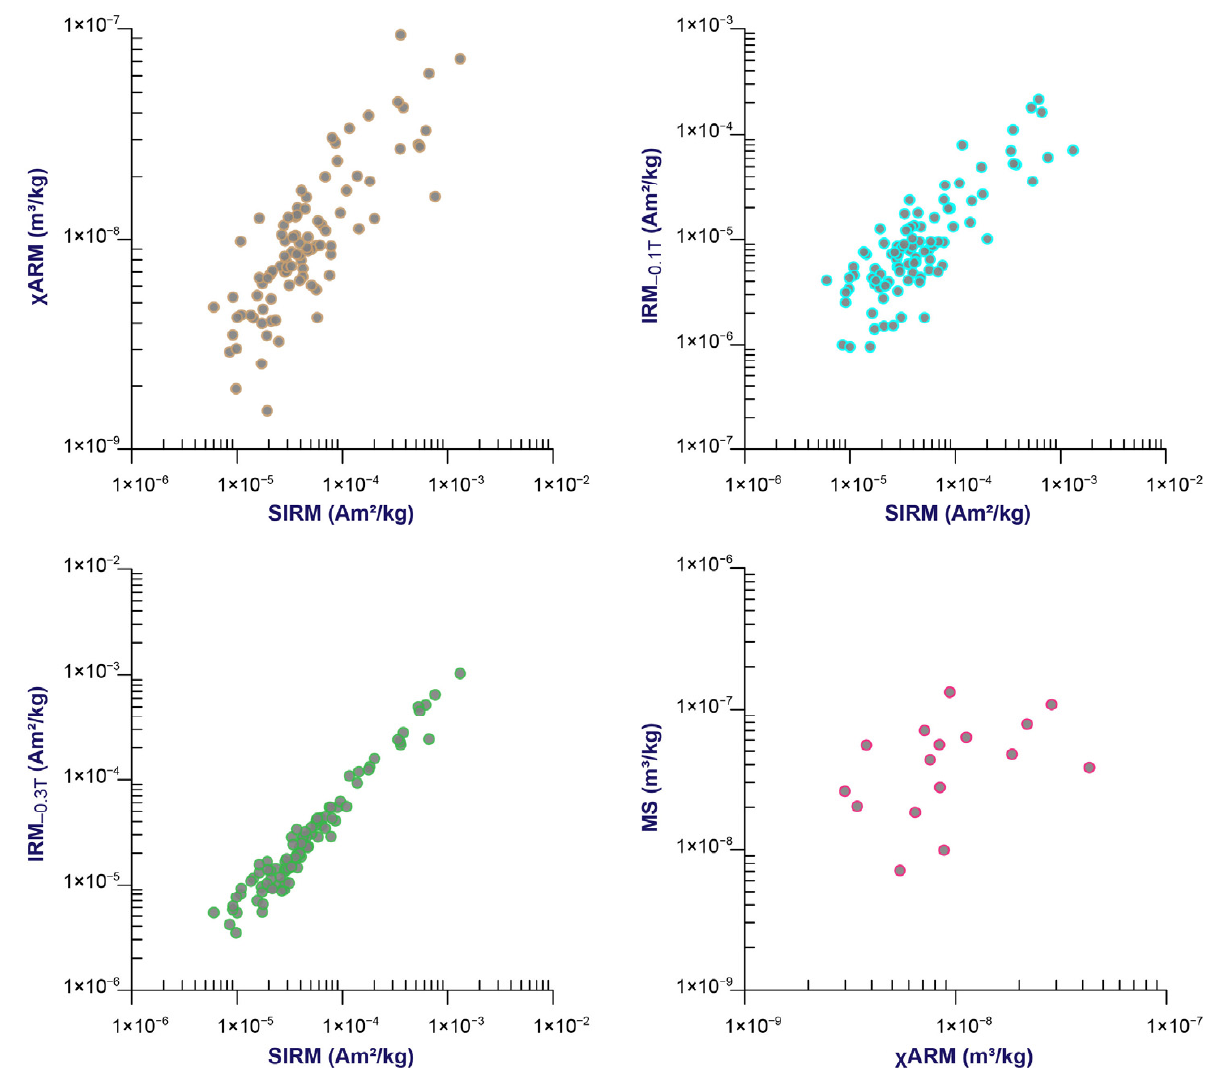
Figure 3. Changes in the magnetic parameters of core XK-1.